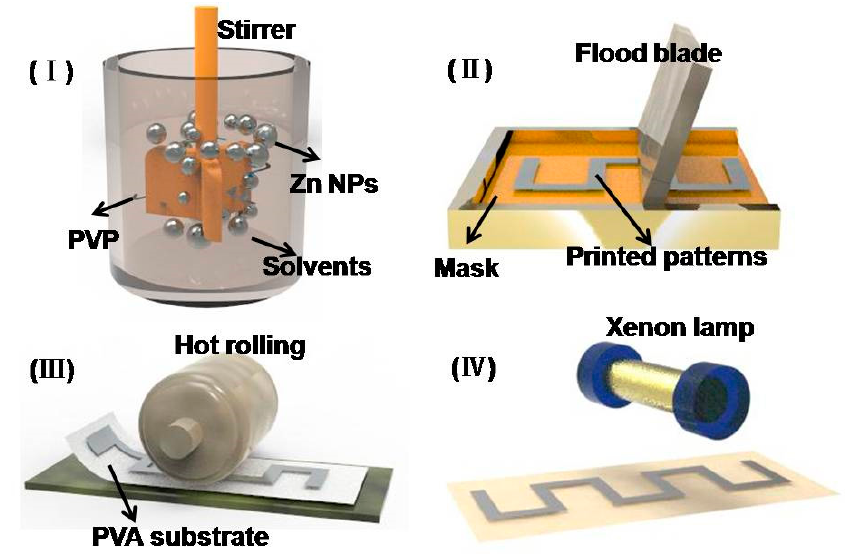
Figure 1. Schematics of fabricating transient electronic patterns through ink preparation ( I ), screen printing ( II ), hot rolling; ( III ) and photonic sintering; ( IV ) approaches.